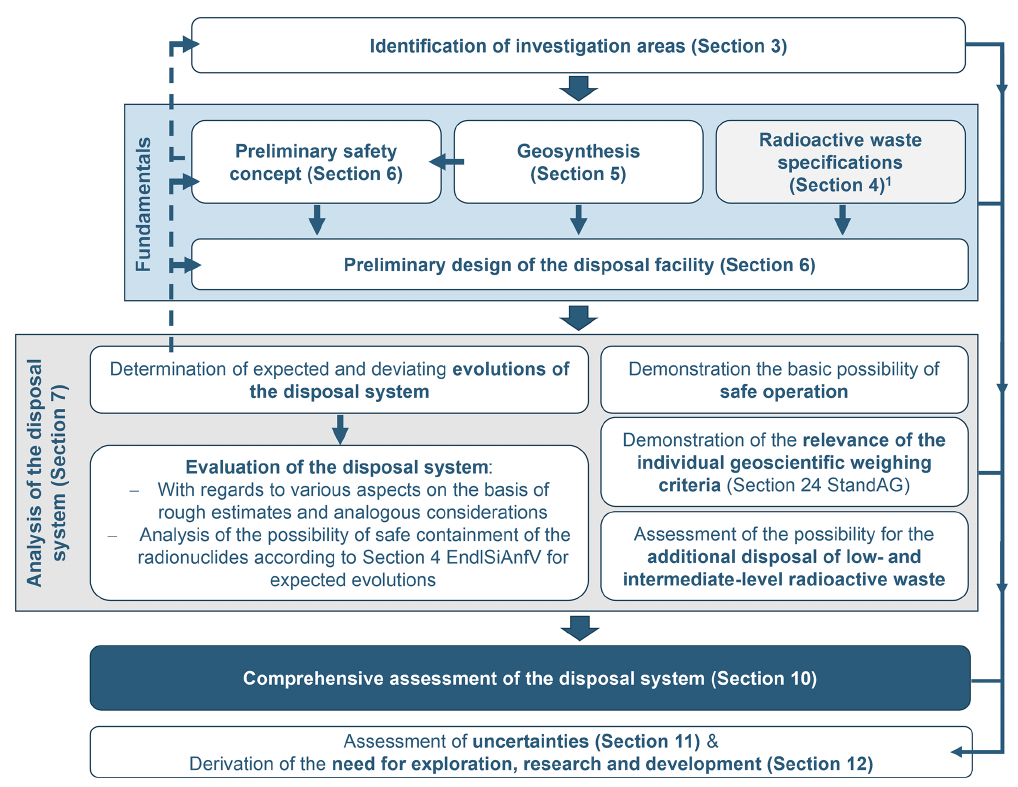
Figure 3. Schematic illustration of the content of the representative preliminary safety analyses according to the Disposal Safety Analysis Ordinance (EndlSiUntV). 1 The radioactive waste specifications can be compiled once, whereas all other steps of the preliminary safety analyses have to be carried out for each investigation